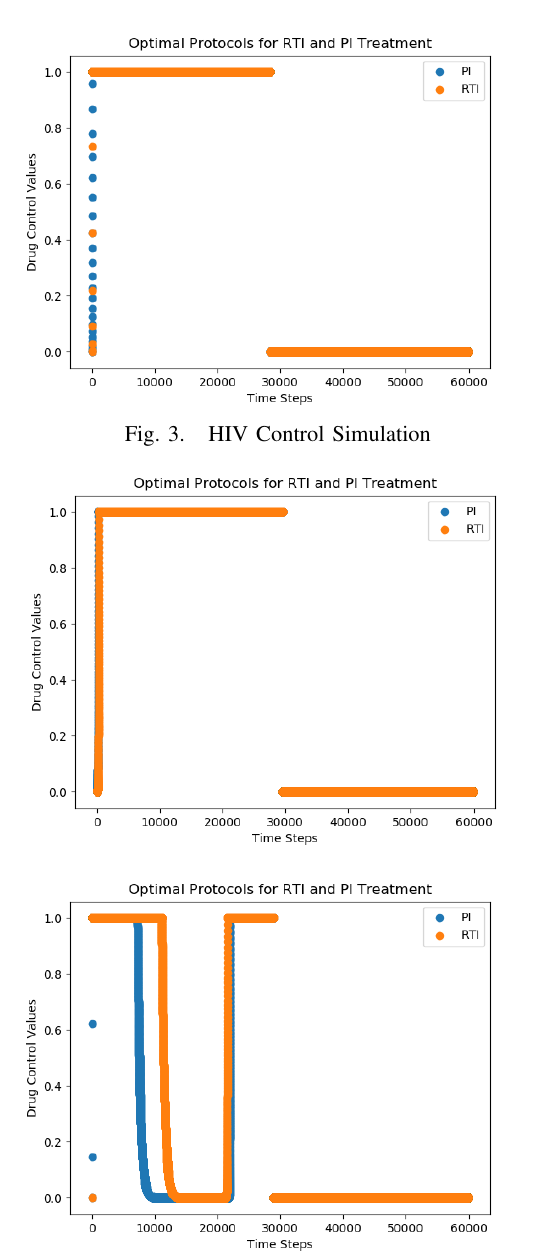
Fig. 4. Impact of Burst Rate of Infected T Cells